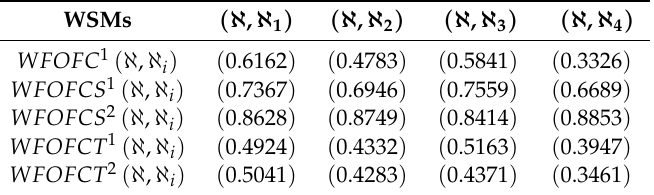
Table 3. Weighted similarity measures of ℵ i with ℵ .